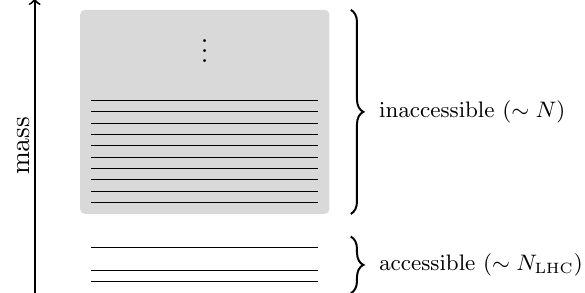
Figure 1. A large N theory where only N gives a production cross section that is suppressed by powers of N